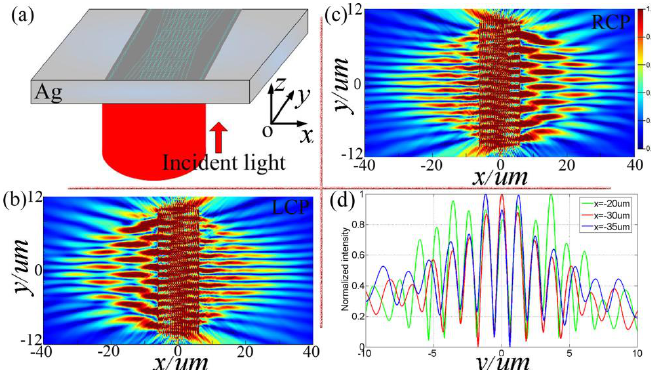
Figure 4. Numerical verifications on the feasibility of simultaneously generating plasmonic Bessel-like beam and plasmonic bottle beam by a single device. ( a ) Schematic diagram of the optical configuration for designed IXI-shaped devices. Numerical simulation results of SPP field intensity distributions generated by LCP light ( b ) and RCP light ( c ). As a comparison, the normalized intensity profiles along y -axis at x = 20 μm , 30 μ m, 35 μ m for RCP light shown in ( c ) are extracted and plotted in ( d ) .